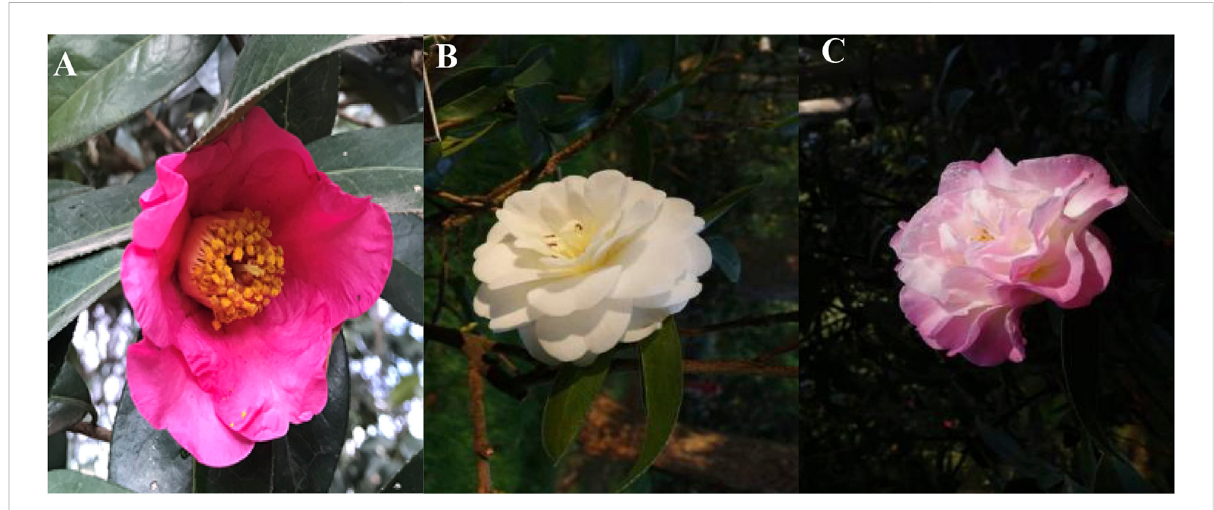
FIGURE 1 Different fl ower colors among three Camellia reticulata. (A) C. reticulata (HHYC), (B) C. reticulata ‘ Tongzimian ’ (TZM), (C) C. reticulata ‘ Xuejiao ’